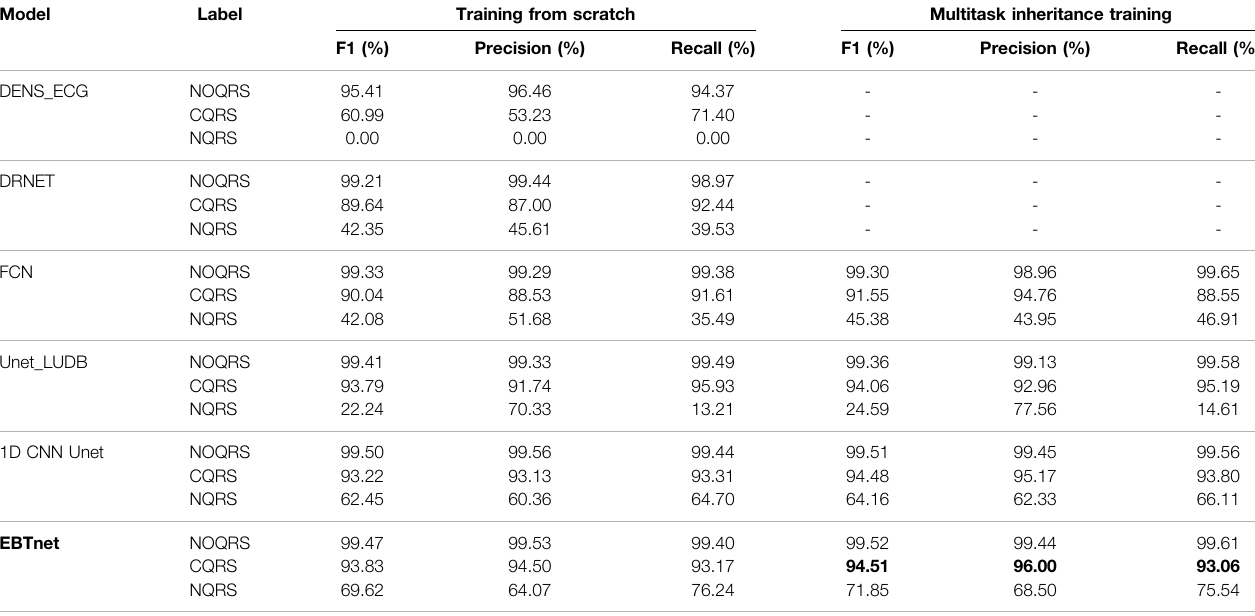
The bold values not in parentheses are the results of our model (EBTnet). And the bold values in parentheses indicate that the results of multi-task inheritance training are better than the results of training from scratch.